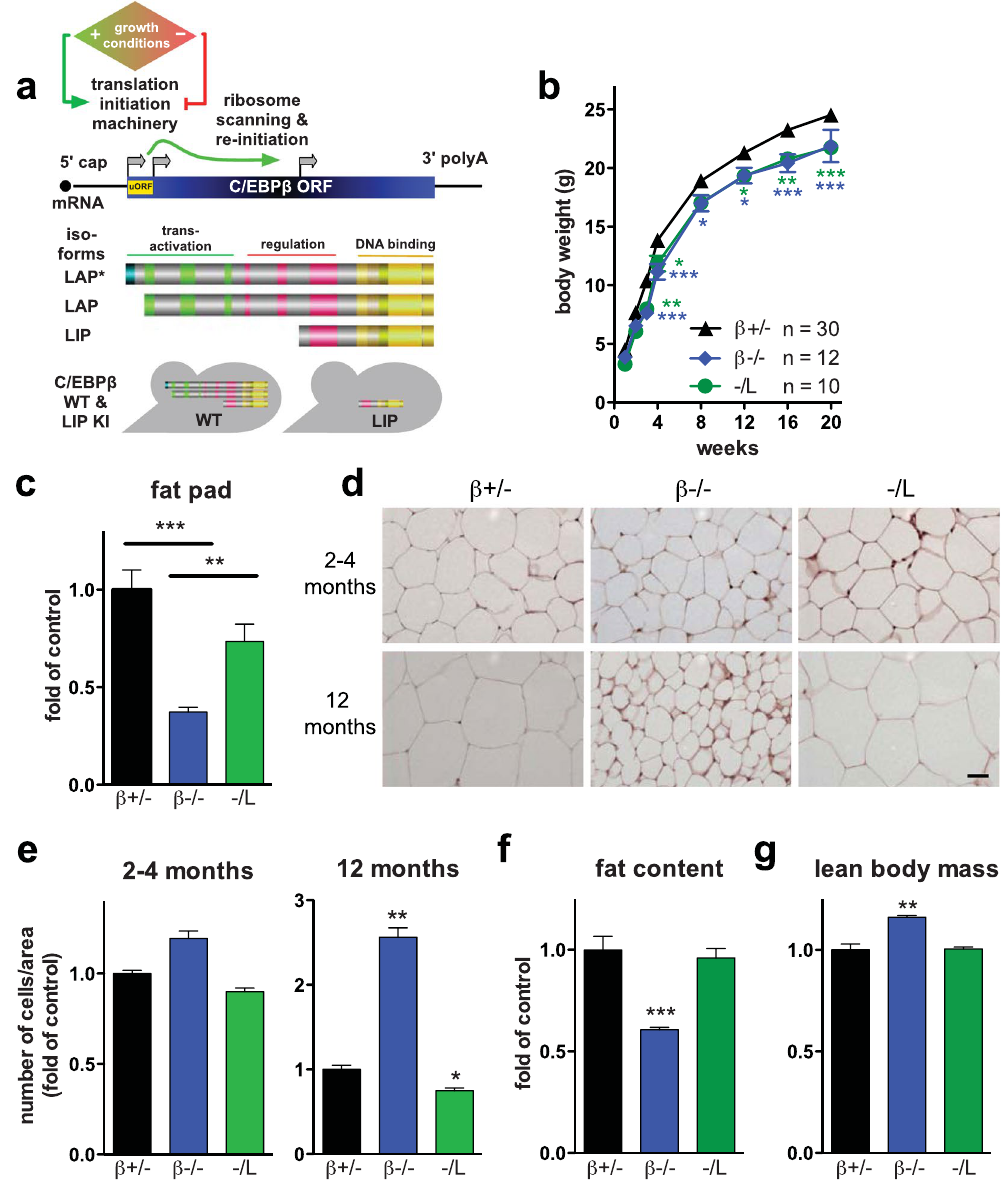
Figure 1. Fat metabolism in Cebpb mutant mice. ( a ) Schematic representation of C/EBP β expression. Environmental conditions regulate the activity of the translation initiation machinery. A cis-regulatory uORF in the single C/EBP β transcript adjusts initiation of translation at conserved in-frame start sites to generate 3 C/EBP β isoforms, as indicated. WT mice produce 3 C/EBP β isoforms, LAP * , LAP, and LIP. The Cebpb LIP knockin mice produce the truncated C/EBP β LIP isoform only, which lacks trans-activating and regulatory C/ EBP β regions. ( b ) Body weight analysis of Cebpb mutant mice. Body weights were recorded weekly between weeks 1 and 4, and then monthly until sacrifice. Statistical differences were assessed by two-way ANOVA within genotype (P < 0.0001) followed by Bonferroni post-hoc test with each time point. ( c ) Gonadal fat pad weight. ( d ) Histomorphometric analysis of white fat sections of Cebpb male mutant mice at 4 and 12 months. Scale bar, 20 μ m. ( e ) Quantification of the fat cell area as shown in ( d ). ( f ) Fat content and ( g ) lean body mass. In all panels, bars indicate mean ± SEM. * P < 0.05, ** P < 0.01, *** P < 0.001 by Student’s t -test. In all panels except where indicated otherwise, mice were 20 weeks of age, n = 6–17 mice per